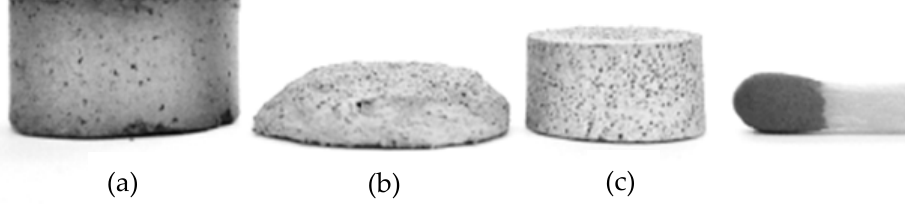
Figure 7. MIM samples: ( a ) unsintered; ( b ) sintered at 1200 °C, 3 h without plasma treatment; ( c ) plasma-treated (15 min, 294 W) and sintered at 1200 °C, 3 h. Adapted and reproduced with permission [27]. Copyright 2017, Elsevier.